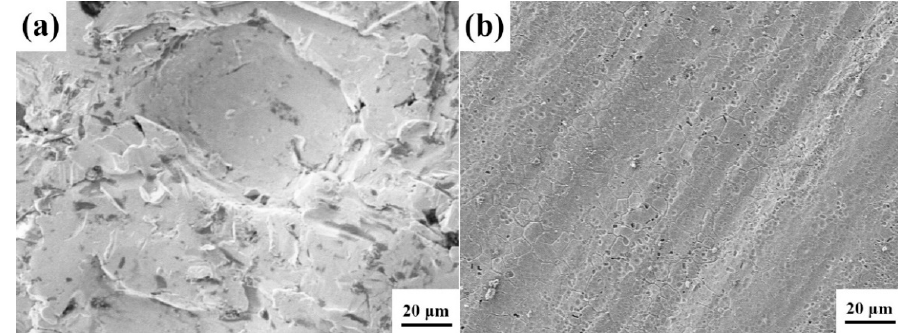
Figure 5. The SEM images at the top surface of ( a ) AWJP and ( b ) UNSM specimens .